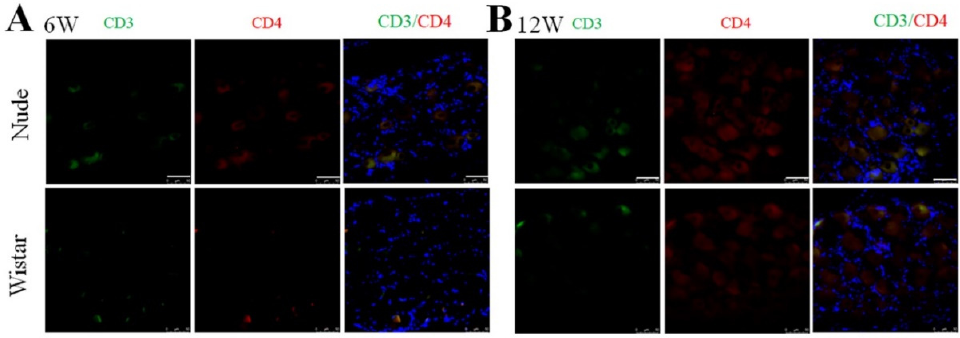
Figure 5. Immunofluorescence staining of CD3 and CD4 cells in DRG. At ( A ) 6 or ( B ) 12 weeks, CD3 and CD4+ cells were not found in either group. Scale bar 50 µ